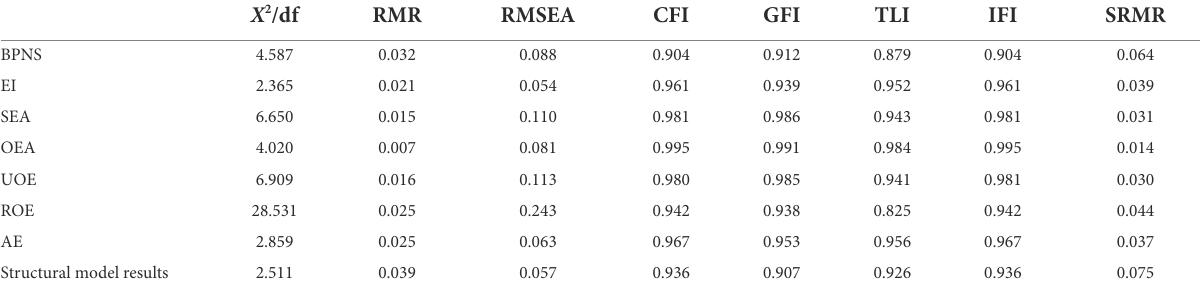
TABLE 4 Measurement model and structural model